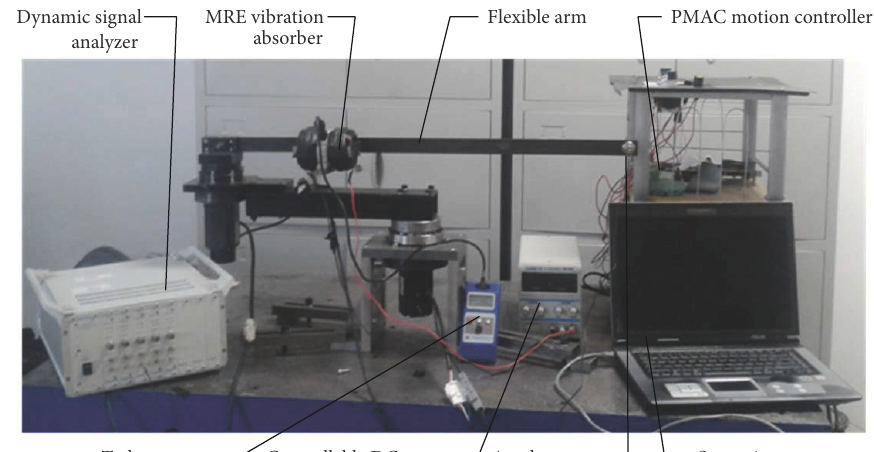
Figure 18: Photograph of the experimental